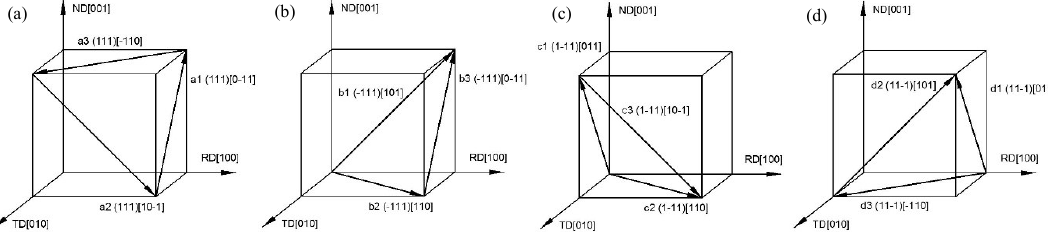
Figure 11. Illustration of {111} planes for initial tensile process: ( a ) (111) slip plane; ( b ) (-111) slip plane; ( c ) (1-11) slip plane; ( d ) (11-1) slip plane.